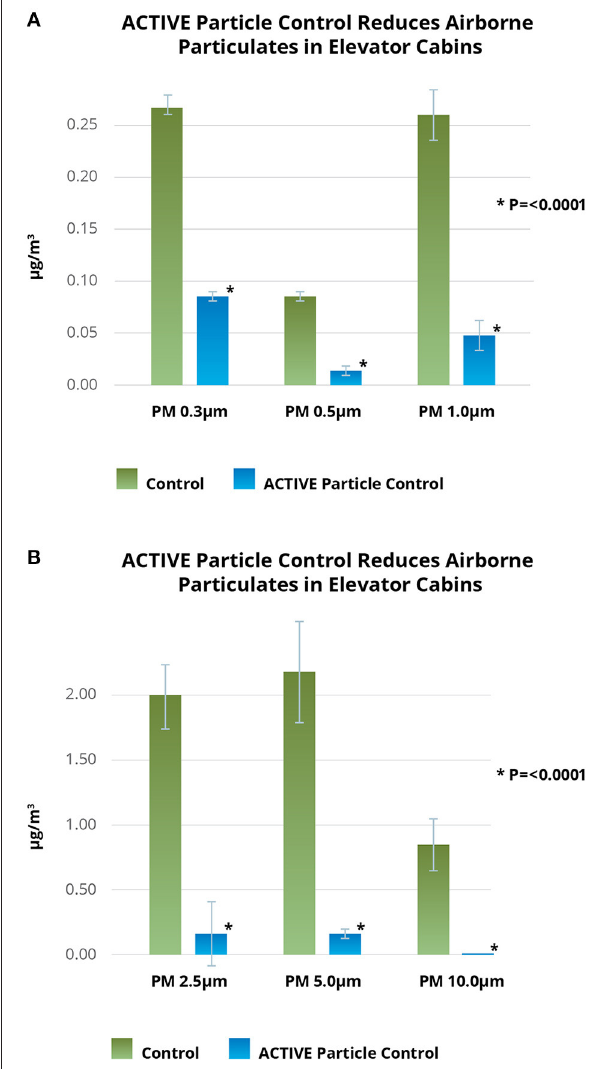
FIGURE 2 | (A,B) ACTIVE Particle Control TM decontaminates elevator cabin air. ACTIVE Particle Control TM reduced sub-micron and supra-micron particles (ug/m 3 ) by 77-100% (mean 88%; p < 0.001) in an active elevator cabin. Each bar represents 100 air samples with a total of 1,200 data points represented in the figure. ACH, air changes per hour; MERV, minimum efficiency reporting value; PM, particulate